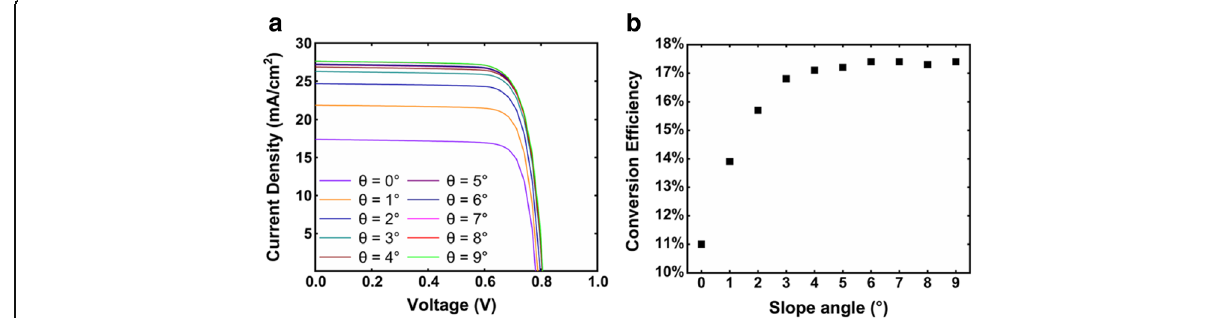
Fig. 9 a Current-voltage curves of radial pin junction nanocone array solar cells with different slope angles. b Dependence of the conversion efficiency on the slope